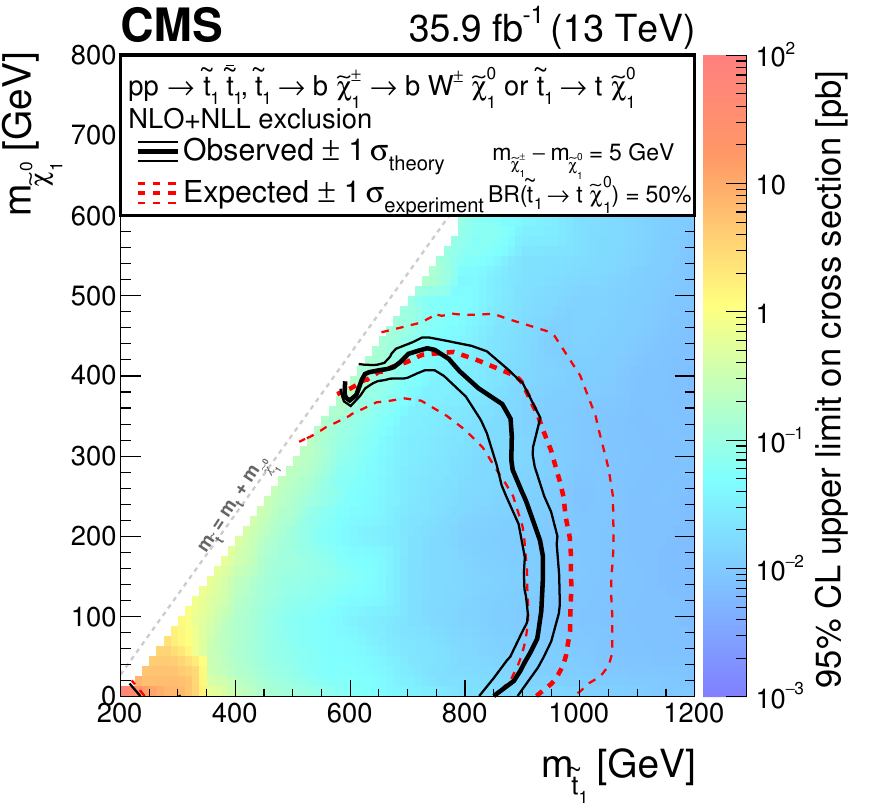
Figure 11 . Exclusion limits at 95% CL for top squark pair production followed by the mixed decay pp ! (cid:31) + (T2tb) decay scenario, in the mass plane m versus m . In T2tb an 1 e t 1 e (cid:31) 0 1 assumption of a compressed mass spectrum in which the mass of (cid:31) (cid:6) is only 5 GeV greater than that 1 of (cid:31) 0 , is considered. The areas to the left and below the solid black curves represent the observed 1 exclusion and the (cid:6) 1 standard deviation contours for the NLO+NLL cross section calculations and e their uncertainties [65]. The dashed red curves represent the corresponding expectation at 95% CL e and (cid:6) 1 standard deviation contours for the associated experimental uncertainties. In the lower left corner of the diagram, where (cid:1) m is close to the top quark mass, the sensitivity of the search is signi(cid:12)cantly reduced due to the fact that the t 1 decay products are soft and often escape detection. e